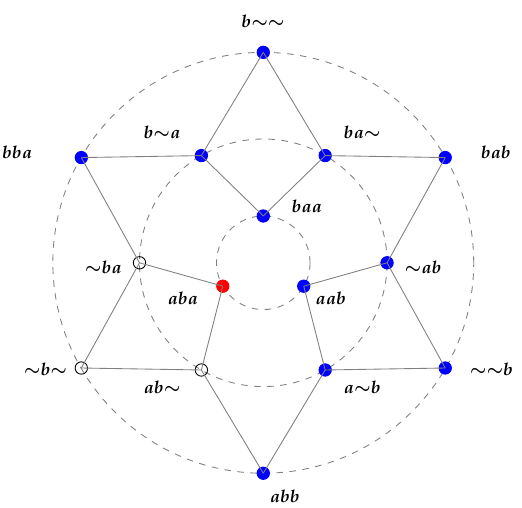
Figure 7. The subcase φ ( aba ) = a and φ ( aab ) = φ ( baa ) = b